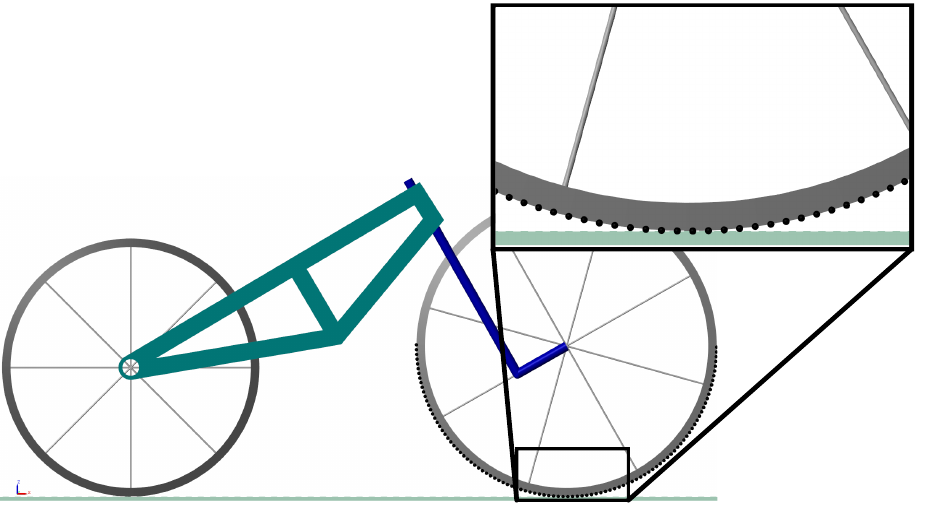
Figure 8. SIMSCAPE MULTIBODY model developed by the authors to reproduce the numerical results of the analytical models proposed in this work. The zoomed window shows the contact proxies used to measure the position vector of the front wheel contact point during the